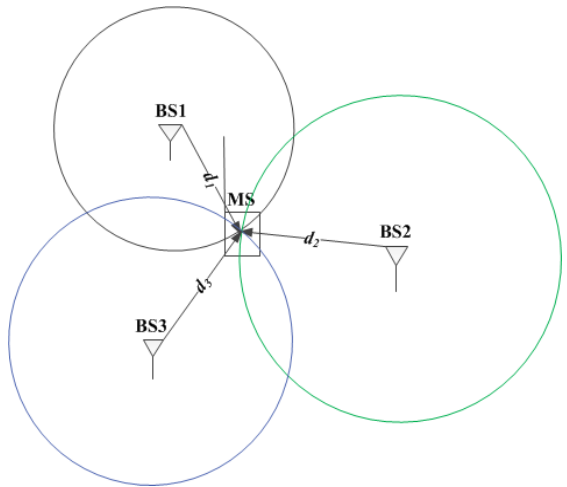
Figure 1. Time of arrival (TOA) trilateration approach for the mobile station (MS) localization.